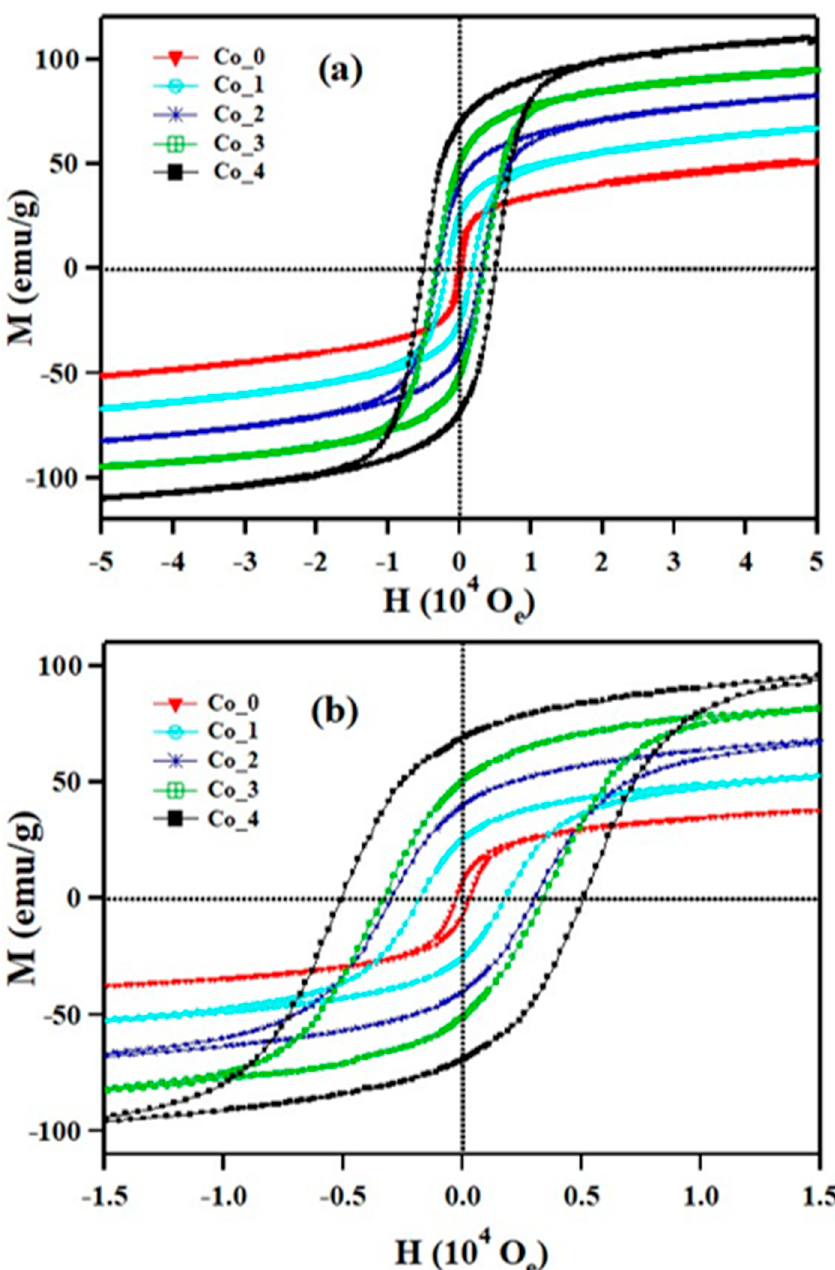
Figure 7. Magnetic field dependence of the magnetization measured at ( a ) 5K (M–H loops) of Co x Zn 1-x Fe 2 O 4 ferrite systems; ( b ) the magnification of the central area of the hysteresis loops.